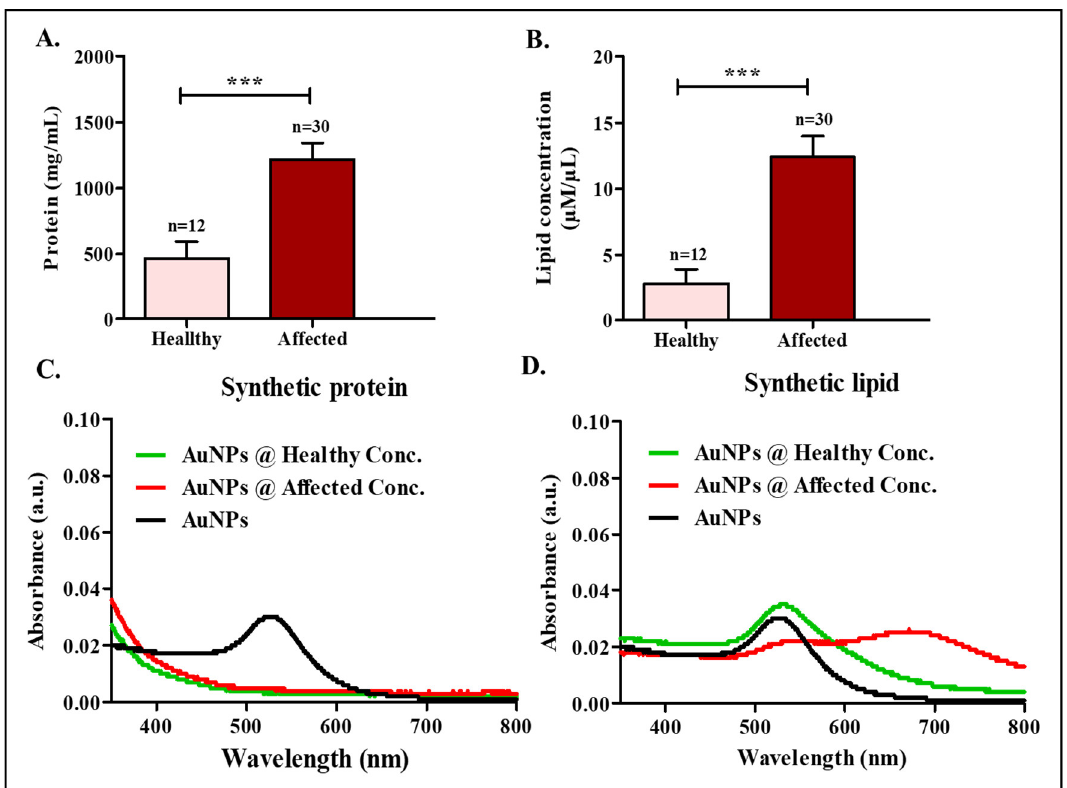
Figure 4. Estimation of ( A ) protein and ( B ) lipid in clinical samples (*** p = 0.0003 for protein analysis and p = 0.0001 for lipid analysis). Absorbance spectra of AuNPs formed with ( C ) synthetic protein and ( D ) synthetic lipid at average concentrations found in clinical samples.